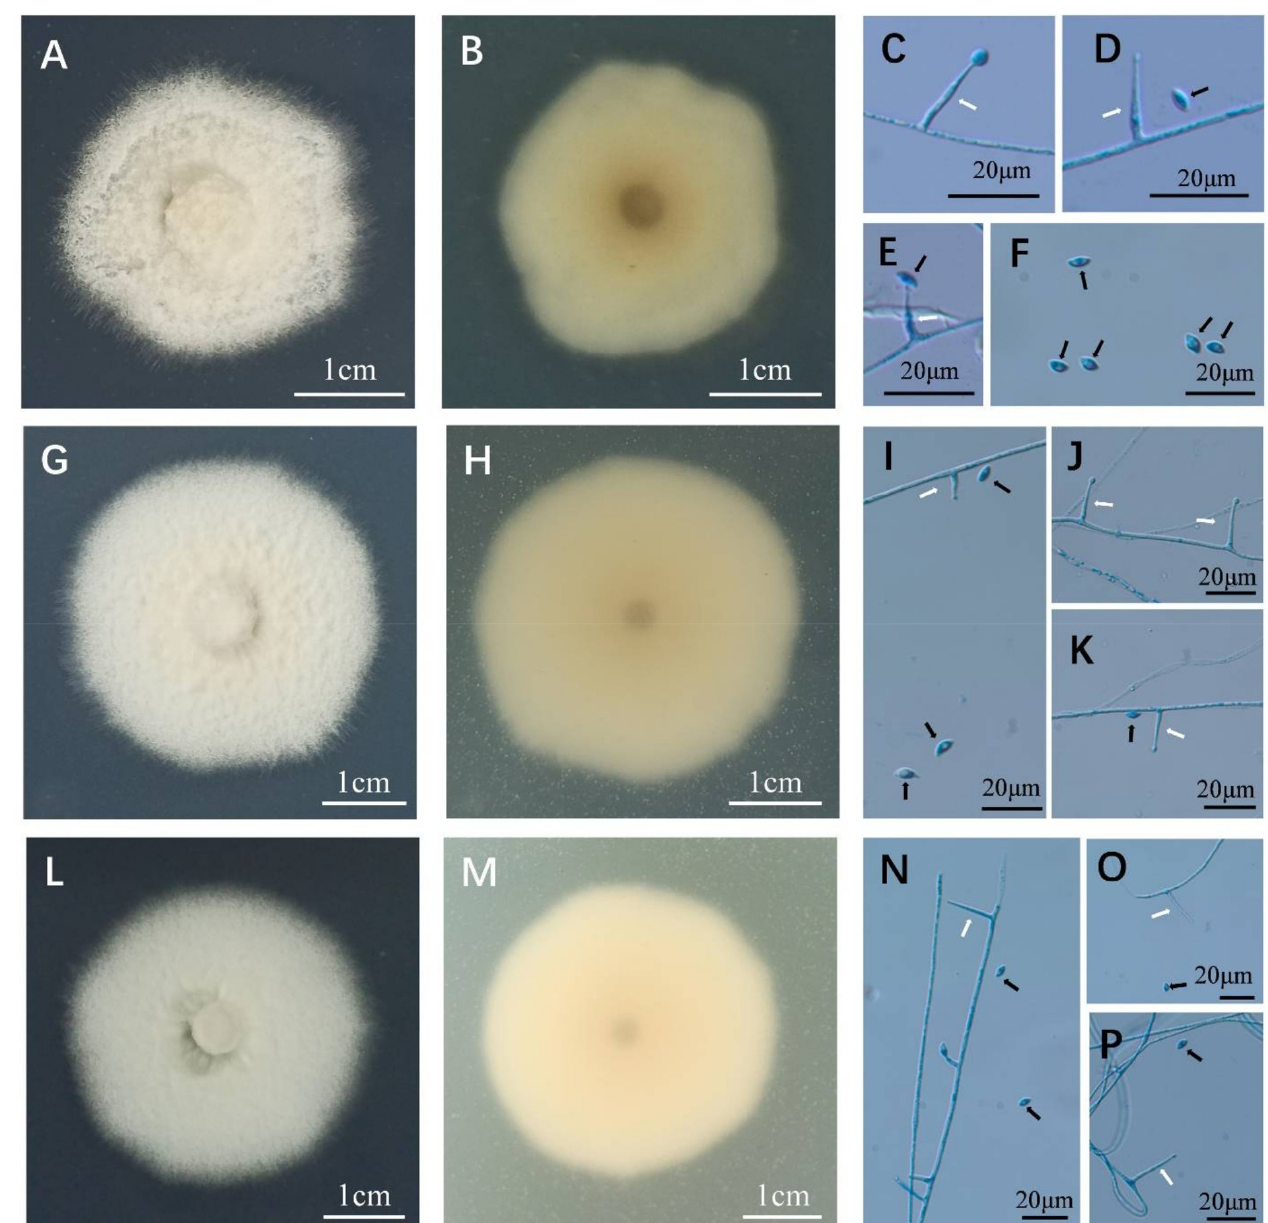
Figure 1. Colony morphology, and conidia and conidiogenous cells of Epichloë sp. HboTG-2 isolates from H. bogdanii . The colony is from cultures grown on PDA at 22 ◦ C for 32 days. ( A ), the surface of D2-1-H; ( B ), the reverse of D2-1-H; ( C – F ), conidia (black arrow) and conidiogenous cells (white arrow) of D2-1-H; ( G ), the surface of D2-2-B; ( H ), the reverse of D2-2-B; ( I – K ), conidia (black arrow) and conidiogenous cells (white arrow) of D2-2-B; ( L ), the surface of D2-1-B; ( M ), the reverse of D2-1-B; ( N – P ), conidia (black arrow) and conidiogenous cells (white arrow) of D2-1-B. The conidia and conidiogenous cells are blue because they were stained with aniline blue